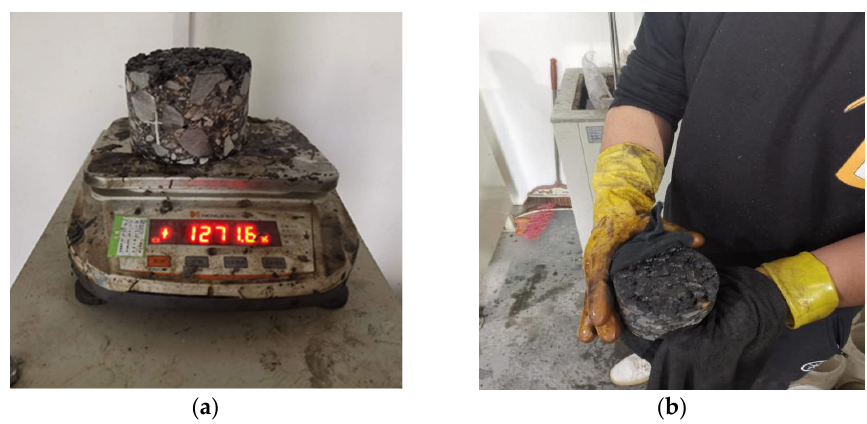
Figure 5. Density testing of the core sample: ( a ) weighing; ( b ) cleaning.